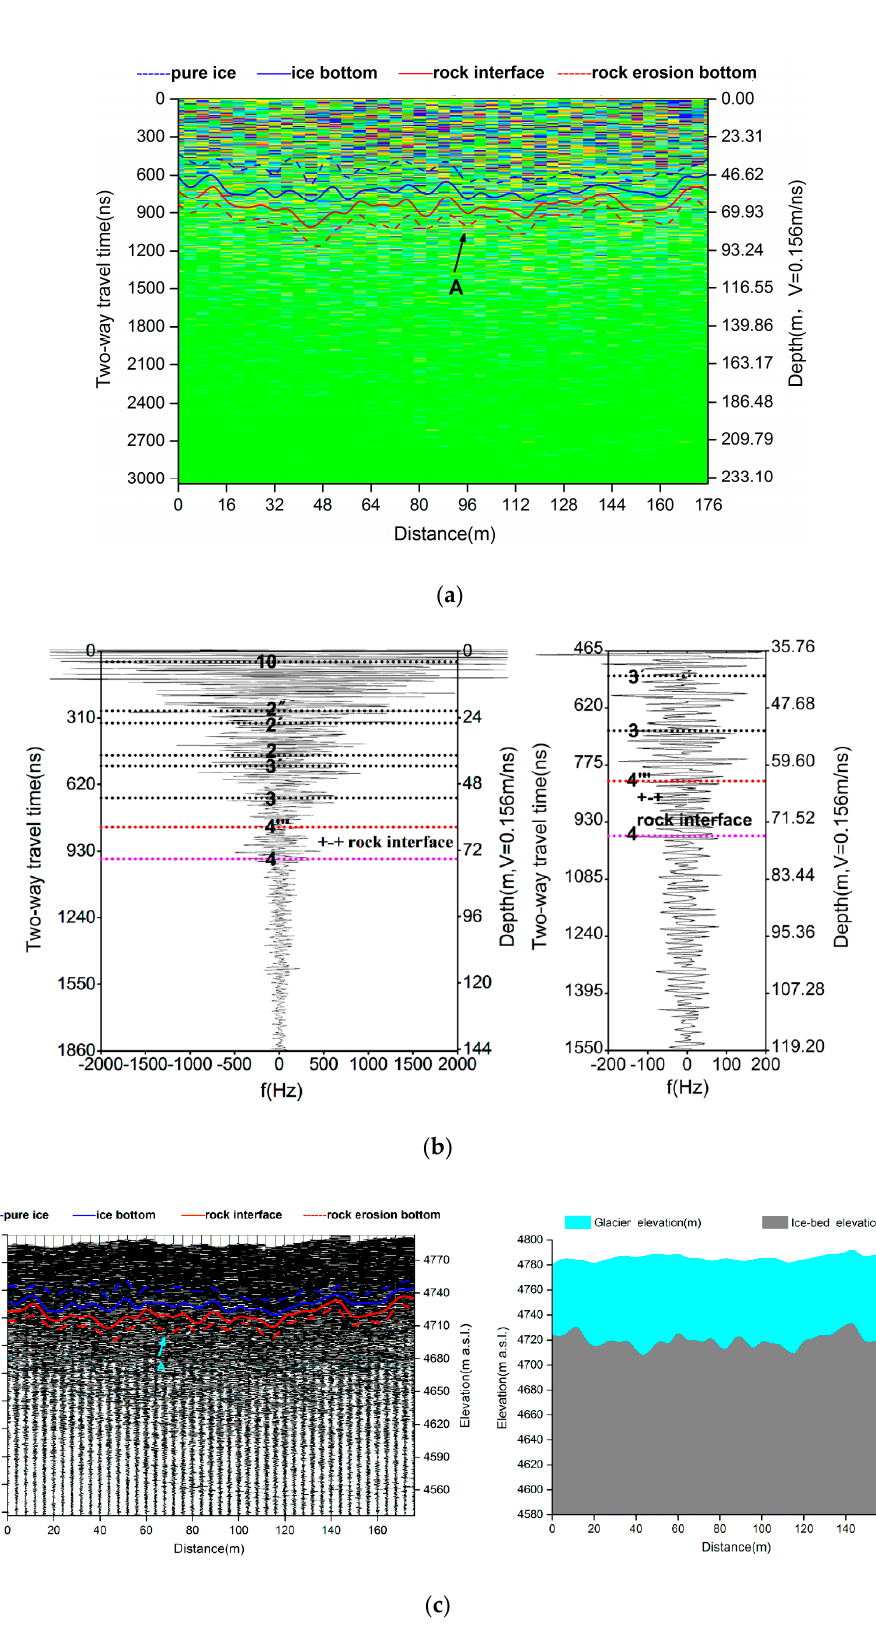
Figure 3. ( a ) The GPR profile and bedrock interface interpretation along transverse profile L1 of BRG1 in Mt. Yulong. ( b ) The five-layer structure interpretation results of the reflected wave trace at the measuring point A of profile L1. ( c ) The GPR profile image after elevation correction, as well as a sketch diagram of the ice surface and the bedrock along transverse profile L1.